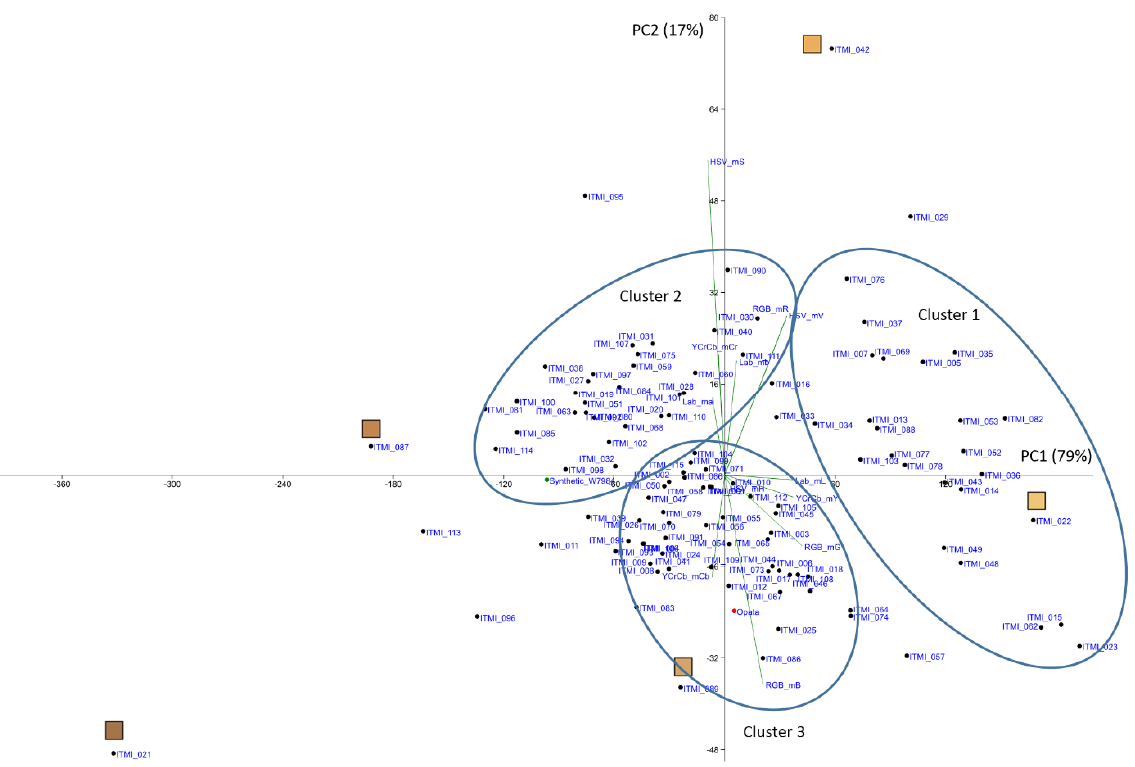
Figure 2. PCA biplot of seed size and shape of ITMI/MP performed using seed 7 coat traits. Ellipses represent seed size and shape for some contrast genotypes in the same scale. Parent genotypes are shown by green (Synthetic_W7984) and red (Opata) dots. PC1, PC2 axes denote principal compo- nents 1 and 2, percentage of variance explained shown in parentheses.